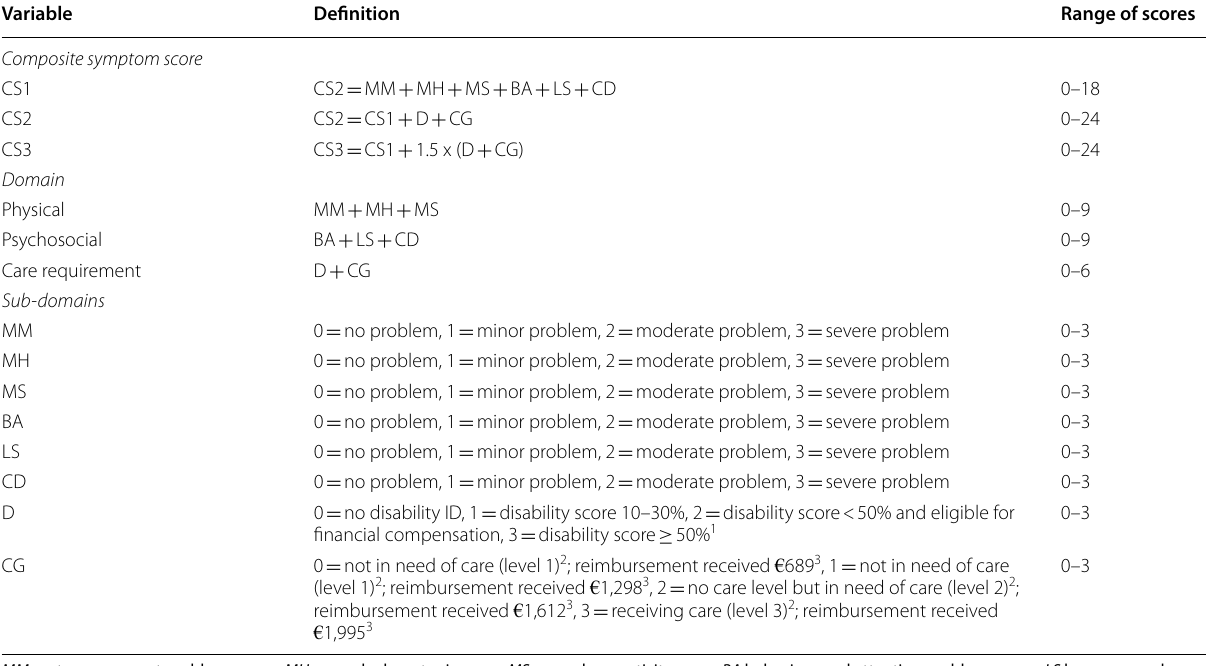
Table 1 Composite symptom scores and their components